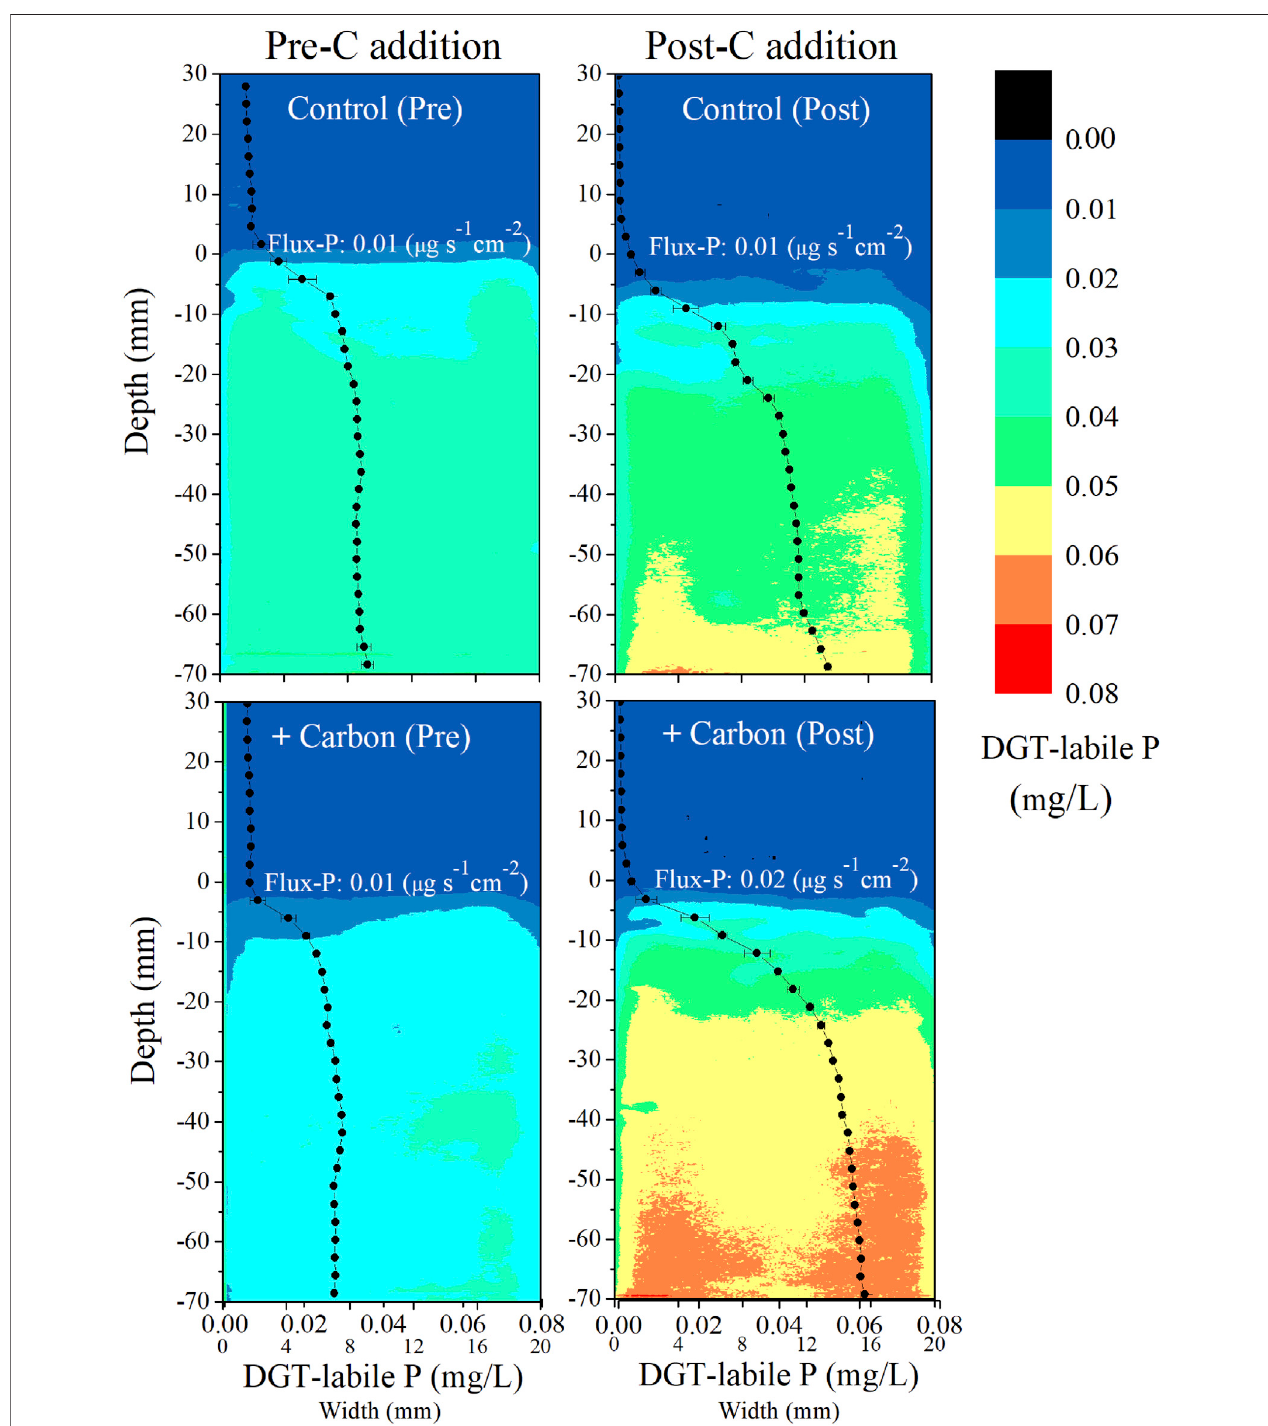
FIGURE2| Two-dimensionaldistributionimagesofDGT-labilephosphorusconcentration(themeanvaluesofthreereplicates)ataspatialresolutionof0.45 mmin sedimentandoverlyingwaterpro fi lesbefore(day1,codedaspre-Caddition)andafterCaddition(day56,post-Caddition).Thelocationofthesediment – waterinterface is represented byzero. Theblack solid dots onthe image represent themeanvalueofDGT-labile phosphorus at the same depth. The valuesof Flux-Prepresentthe fl ux of phosphorus across the sediment – water interface (the negative and positive values represent the fl ux to the sediment and water, respectively).